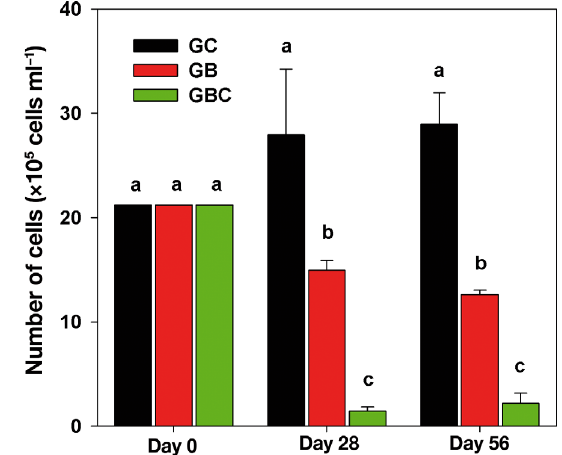
Fig. 1. Number of microalgae cells (mean ± SD) in different groups (see Table 1) on Days 0, 28, and 56. Different lower- case letters indicate significant differences among treatment groups at the same sampling time (ANOVA, p <